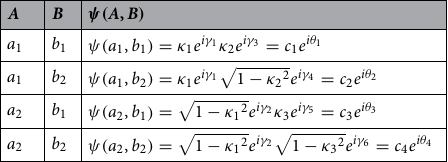
Table 2. Wave functions in the BEQBN model presented in Fig.